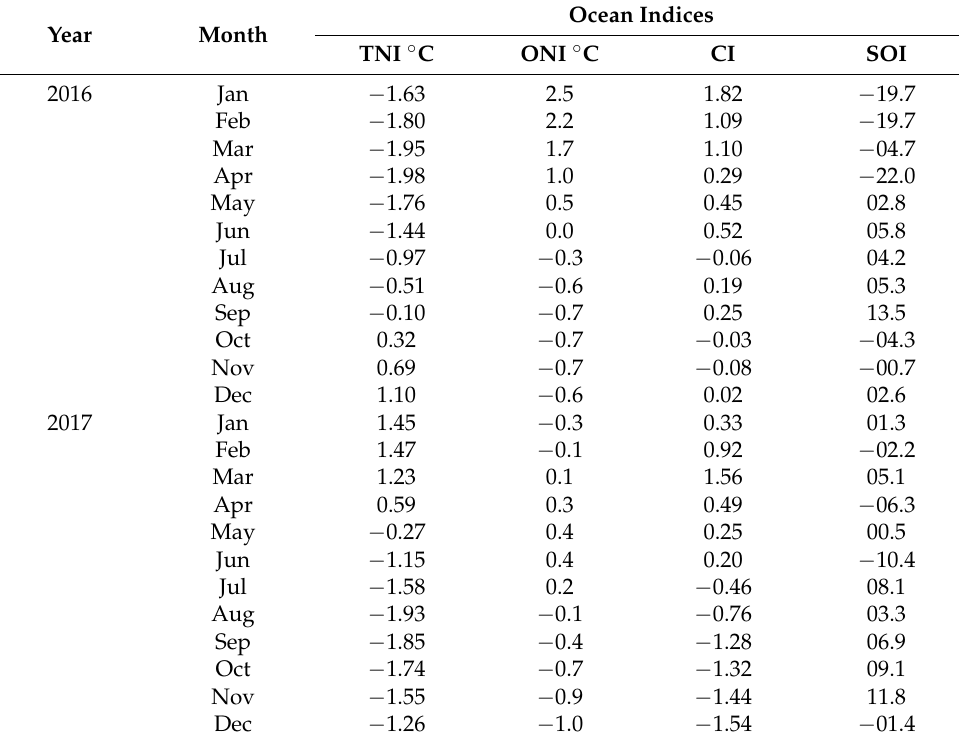
Table A1. Indices Values, from 2016 to 2017.